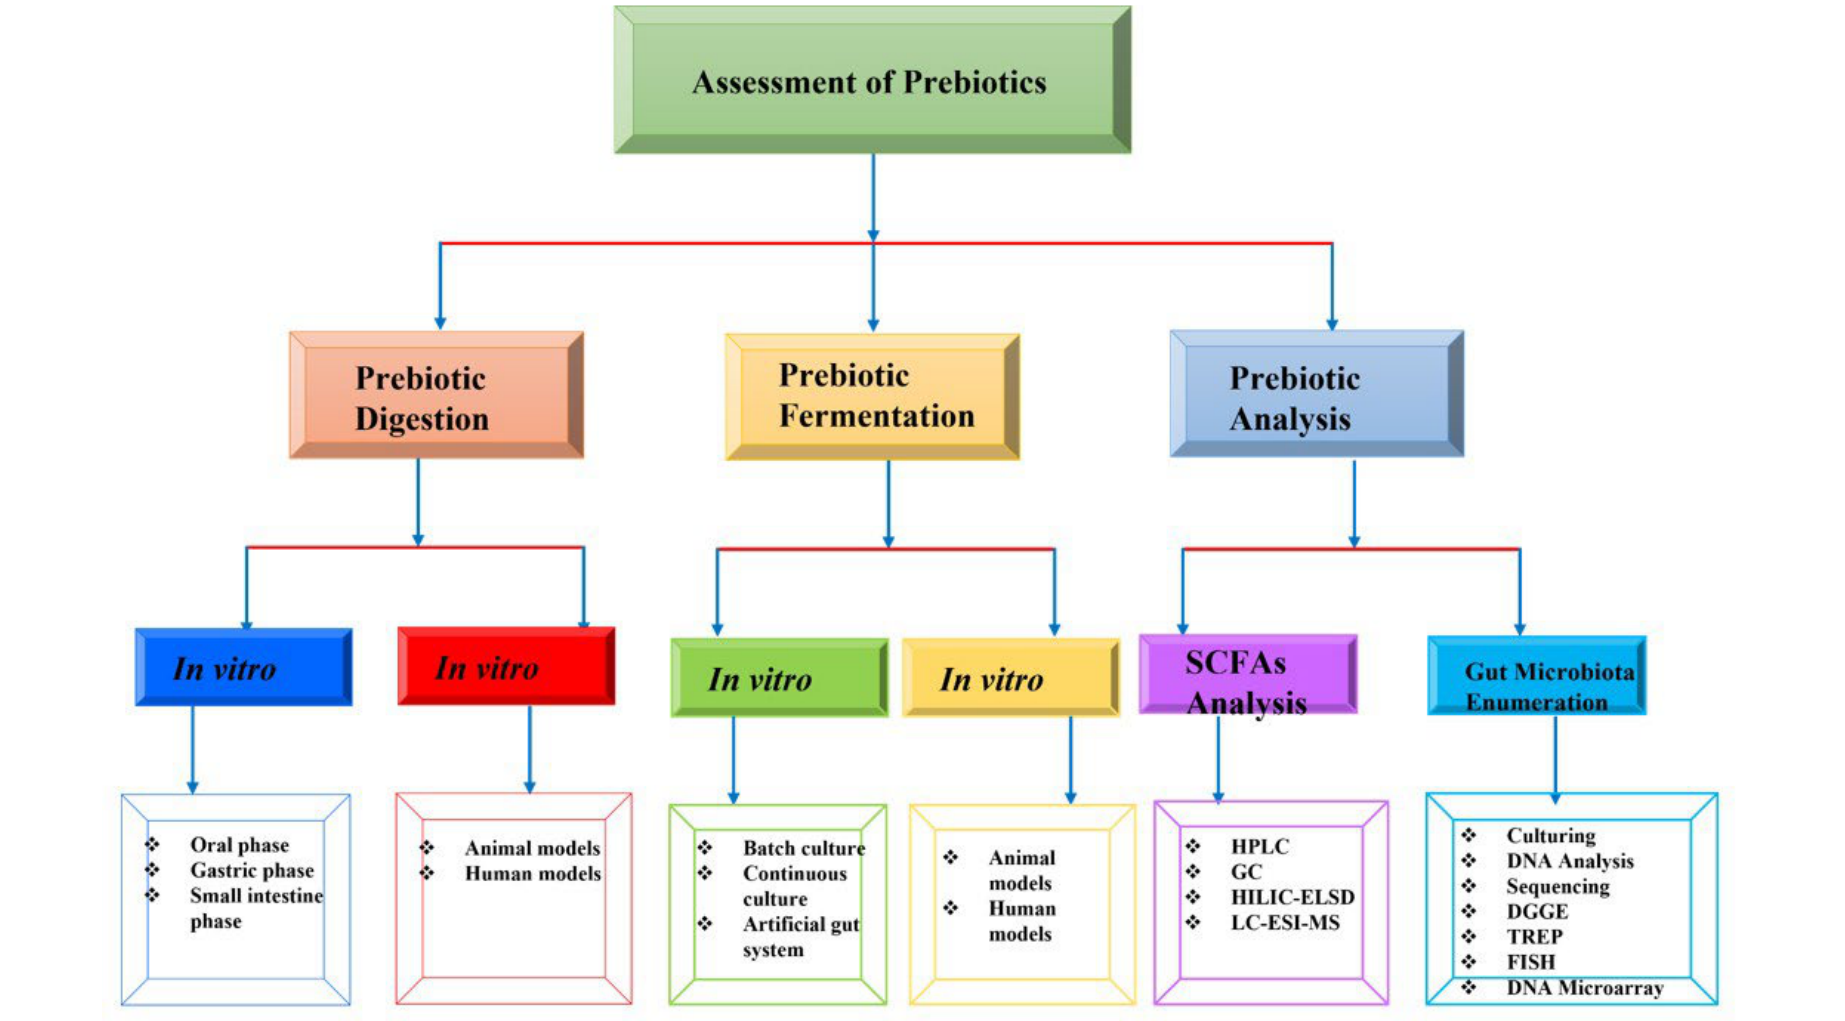
Figure 2. Assessment of the efficacy of prebiotics.